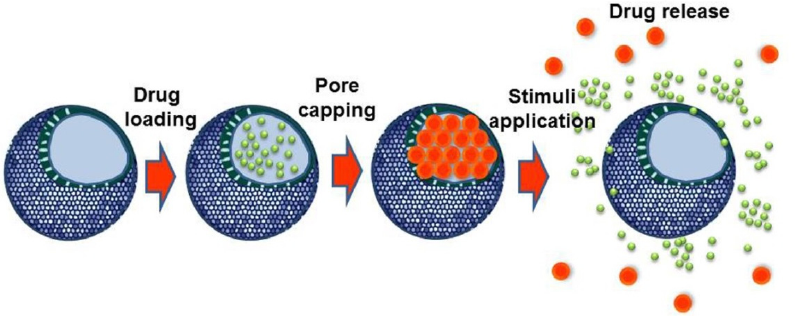
Figure 5. Schematic representation of the performance of stimuli-responsive